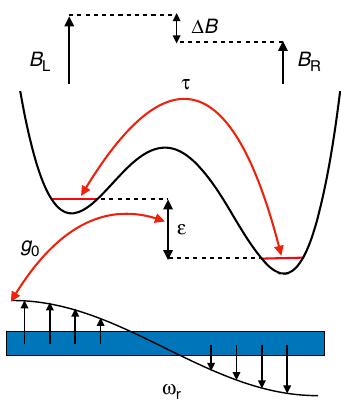
Fig. 1 Double-dot device schematic, including an optional coupling to a superconducting microwave resonator. A singlet-triplet qubit is formed in a double dot containing two electrons. ε is the detuning between the two sides of the device, τ is the corresponding tunnel coupling, Δ B is the Zeeman energy associated with the inter-dot magnetic fi eld difference (or gradient), and g is the optional capacitive coupling between a qubit 0 plunger gate and the anti-node of a resonator of frequency ω r , which can be used to mediate two-qubit gate